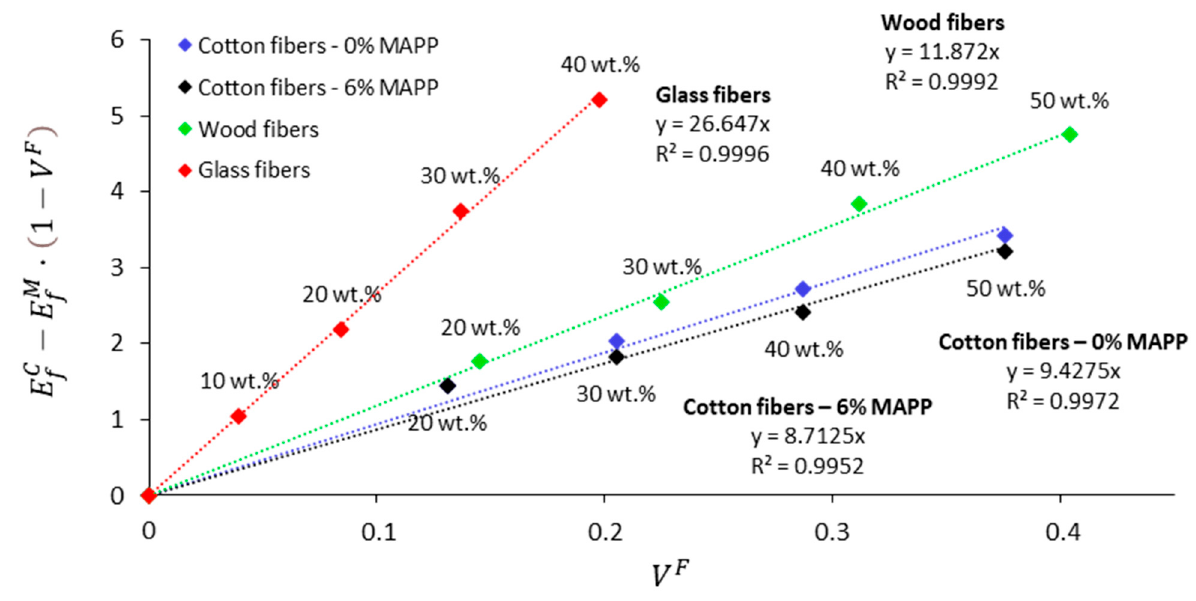
Figure 4. Representation of the Fiber Flexural Modulus Factor (FFMF) of cotton fibers, wood fibers, and glass fibers as PP reinforcement.